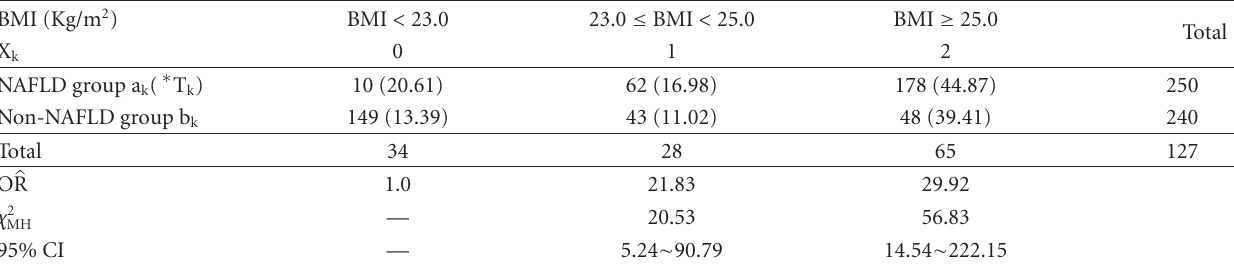
Table 2: Correlation between BMI and